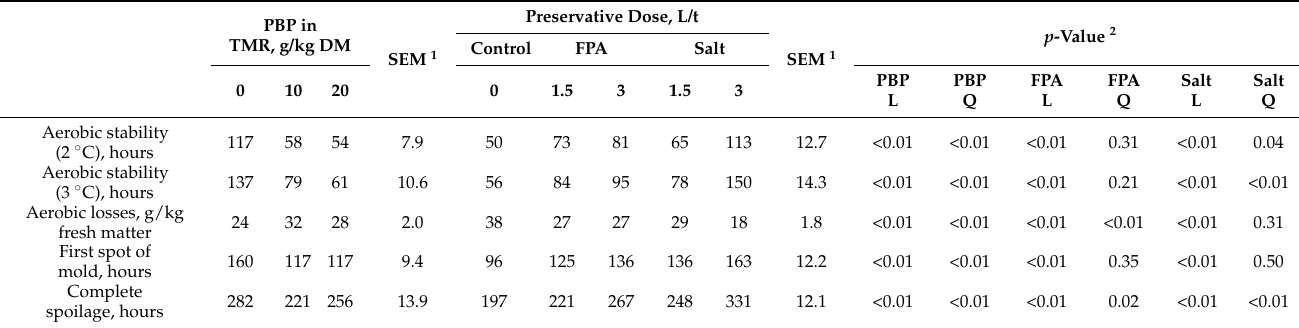
Table 8. Aerobic stability and losses, and visual spoilage of total mixed rations with incremental proportions of potato by-product (PBP) and treated with formic and propionic acid-based (FPA) or salt-based (Salt) preservatives (Experiment 2).